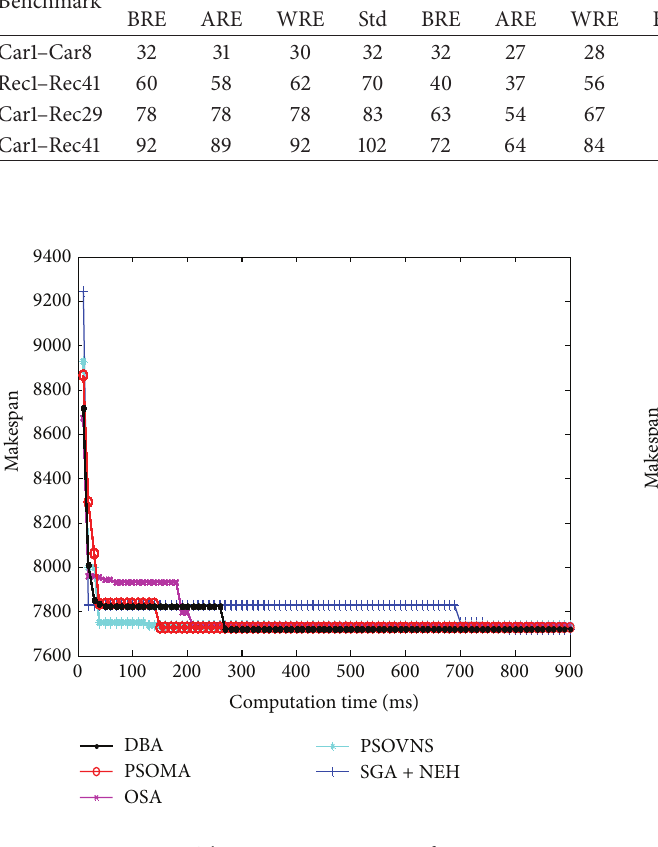
Figure 10: The convergence curves of Car5.